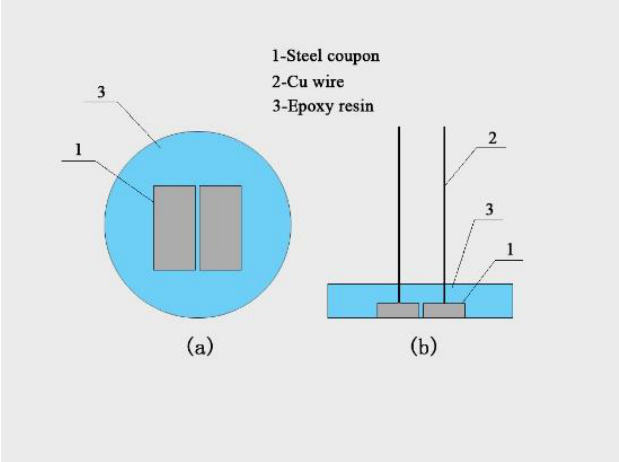
Figure 1. Schematic diagram of the steel coupon with main ( a ) and side ( b )